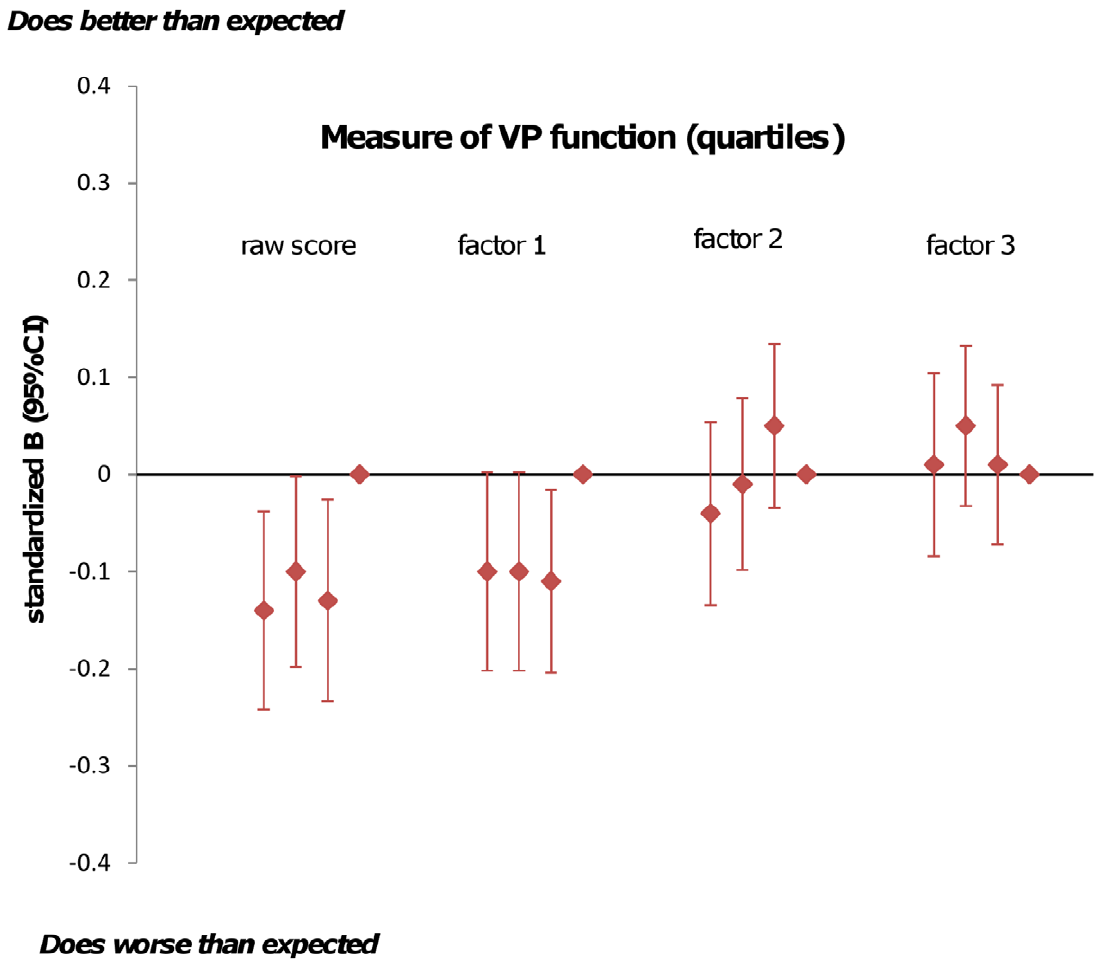
Figure 3. Parameter estimates for measures of visual perception (in quartiles) as predictors of school mathematics test results. Analyses adjusted for age at KS3 testing; Gender; Maternal education; Highest maternal/paternal social class; ICD10 diagnosis; visual problems, born at less than 37 weeks gestation; admitted to a Special Care Baby Unit in first month; low birthweight; IQ.